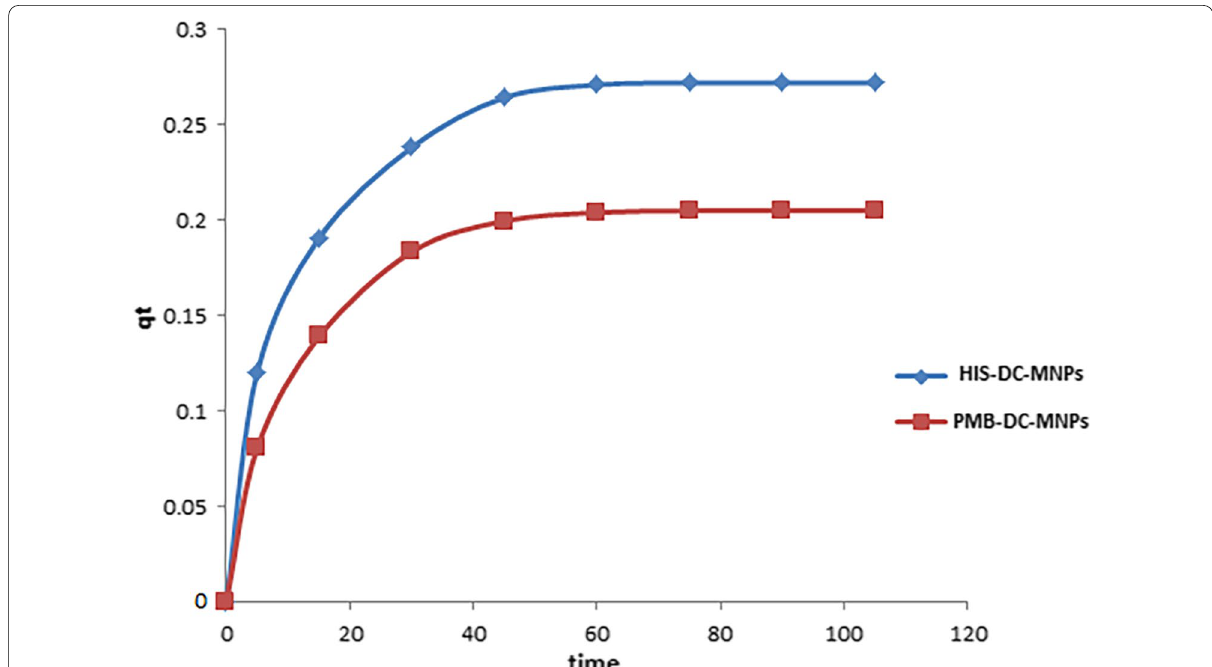
Fig. 8 Adsorption capacity showing (qe calc